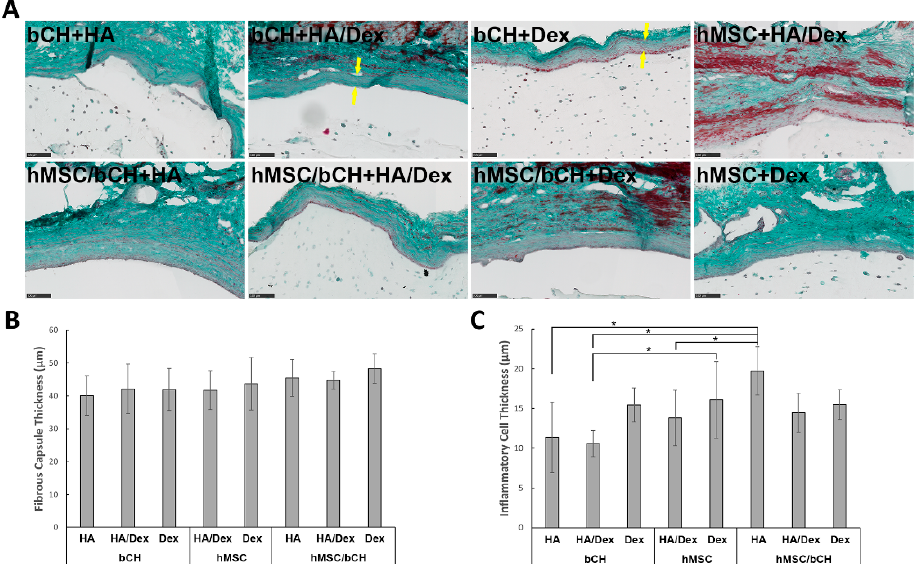
Figure 4. Histological characteristics of implant fibrous capsule after 28 days of subcutaneous implantation. (A) Representative Masson–Goldner trichrome staining of all hydrogels. All images show the interface between the host tissues (top of images) and the implant. As a result of the staining protocol, nuclei will be stained in dark brown to black, cytoplasm and muscles will appear brick red, the connective tissue will appear green, and erythrocytes will be bright orange. Yellow arrows in the stained sections indicate the fibrous capsule at the material/host interface. The thickness of the fibrous capsule (B) and the inflammatory cell layer (C), shown in Figure 2 with yellow arrows, were measured for sections of all conditions. Data are presented as mean with standard deviation as error bars for n = 10 biological replicates per hydrogel condition. Scale bars represent 100 µ m. * represents p <